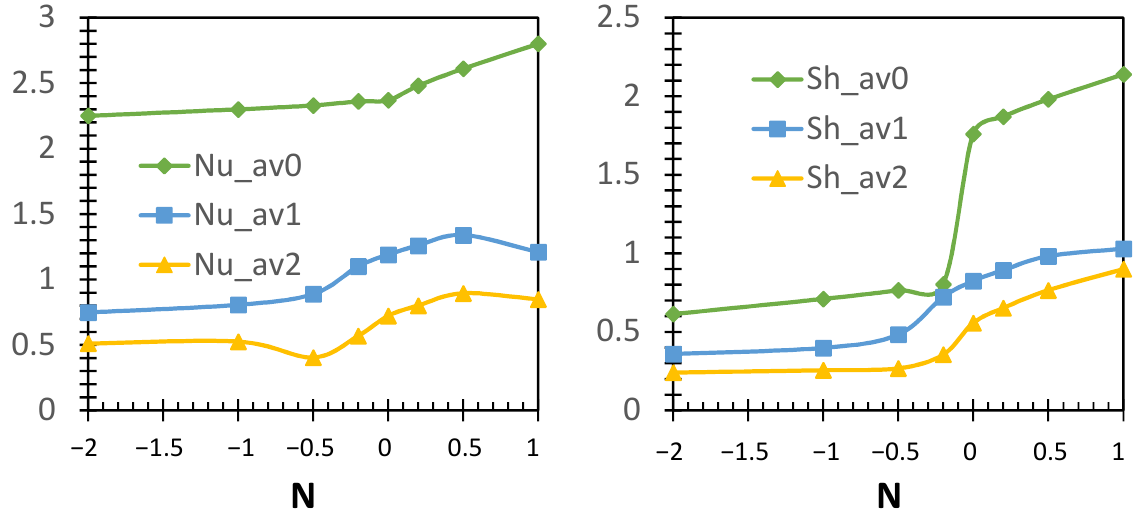
Figure 18. Effect of the buoyancy ratio on the average heat and mass transfer ratios for Ra = 2 × 10 4 , (0): reference case, (1): H 1 = 0.25 and (2) for H 2 = 0.5.